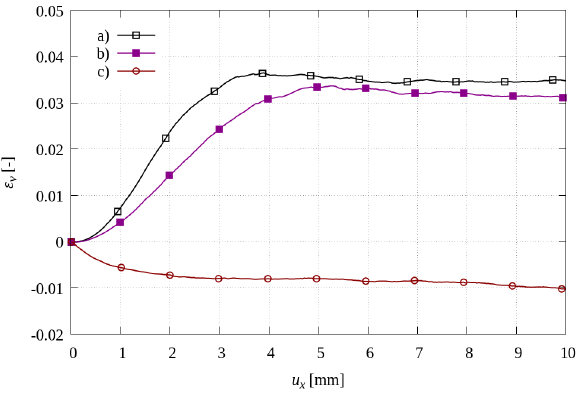
versus horizontal displacement u Figure 12: Volumetric strain ε v x from discrete simulations of direct shear test for different initial void ratios: a) e = 0.53, b) e = 0.60 and c) e = 0.75 (σ = 200 kPa, d = 0 0 0 0 50 0.5